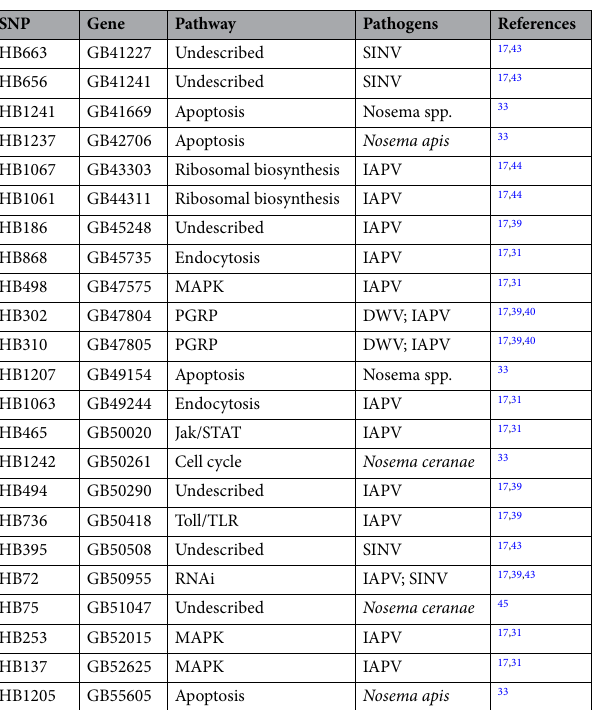
Table 2. SNPs mapped to genes differentially expressed in honey bees infected by different